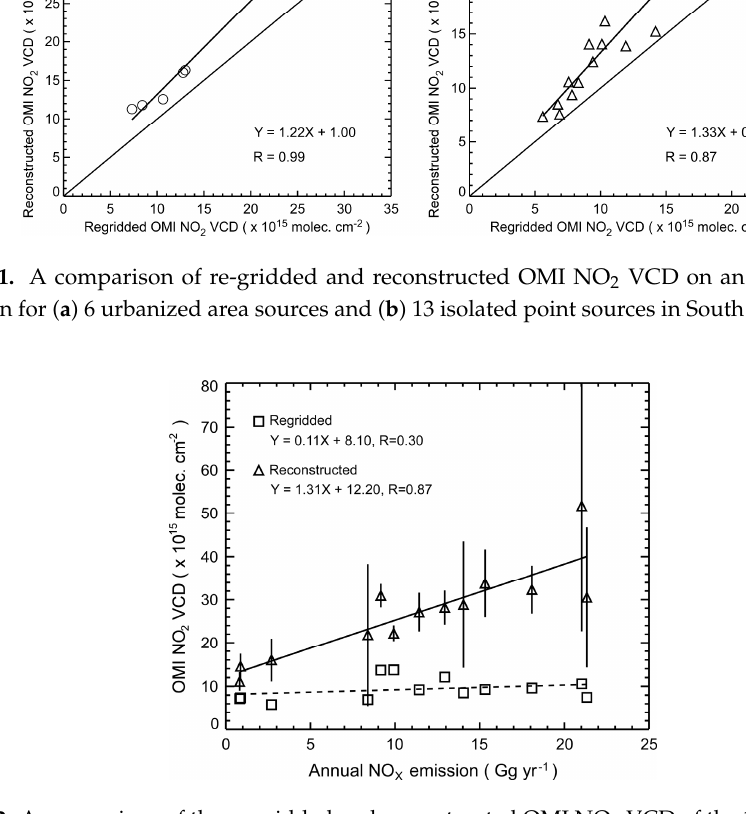
Figure 12. A comparison of the re-gridded and reconstructed OMI NO 2 VCD of the 13 major isolated point sources in South Korea against their annual NO X emissions. The vertical bar denotes the downscaling uncertainty estimated for the fine-scale reconstructed OMI NO 2 product.